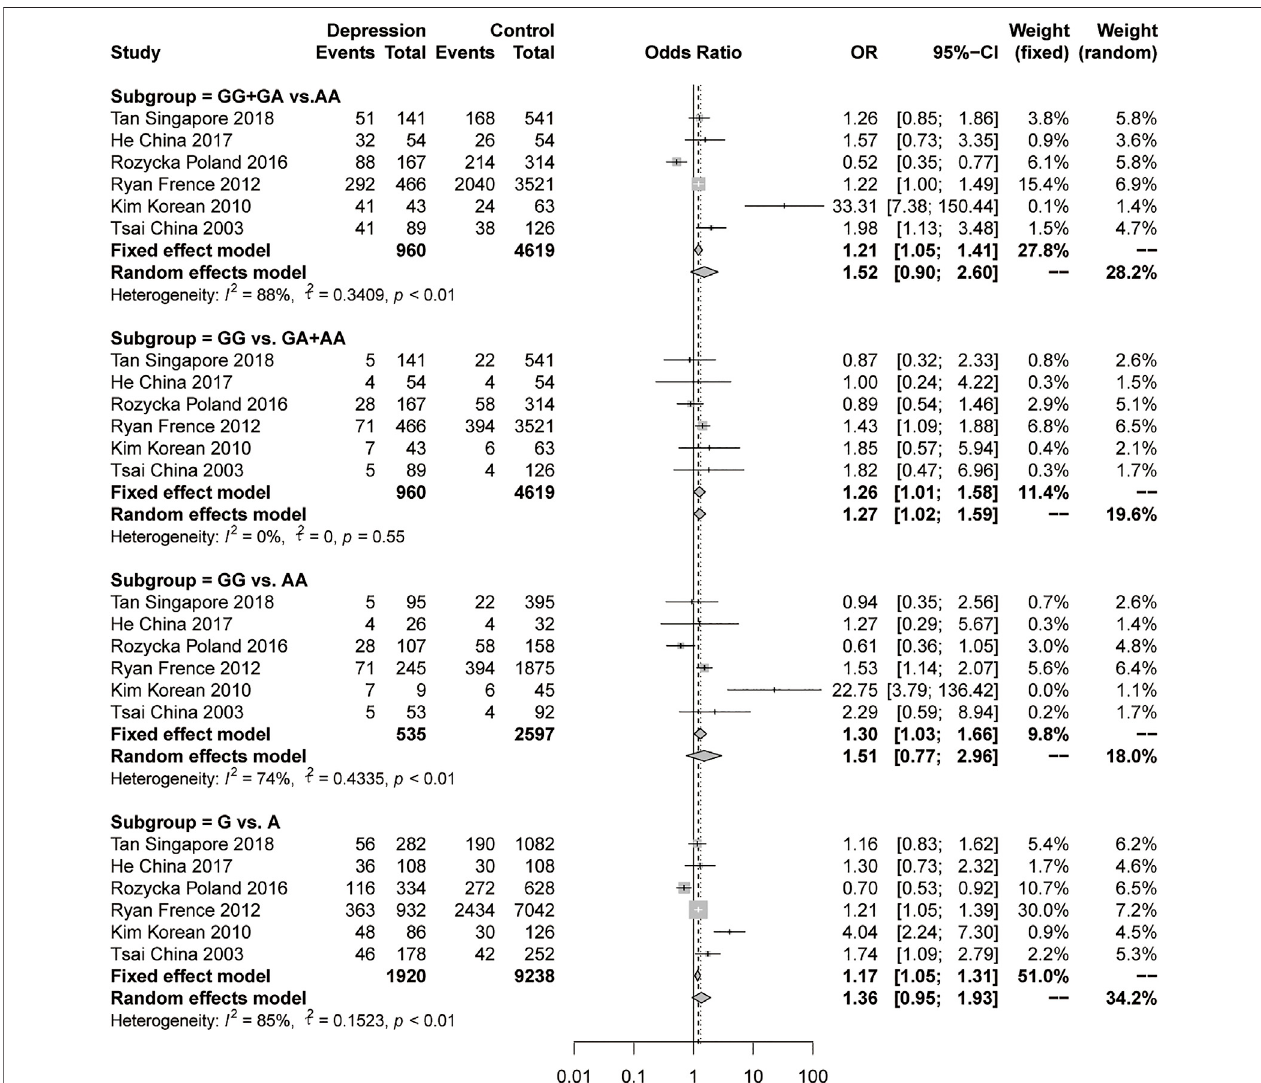
FIGURE 3 | Forest plot of studies comparing the distribution of the rs9340799 polymorphism of ER α between women with depression and controls.